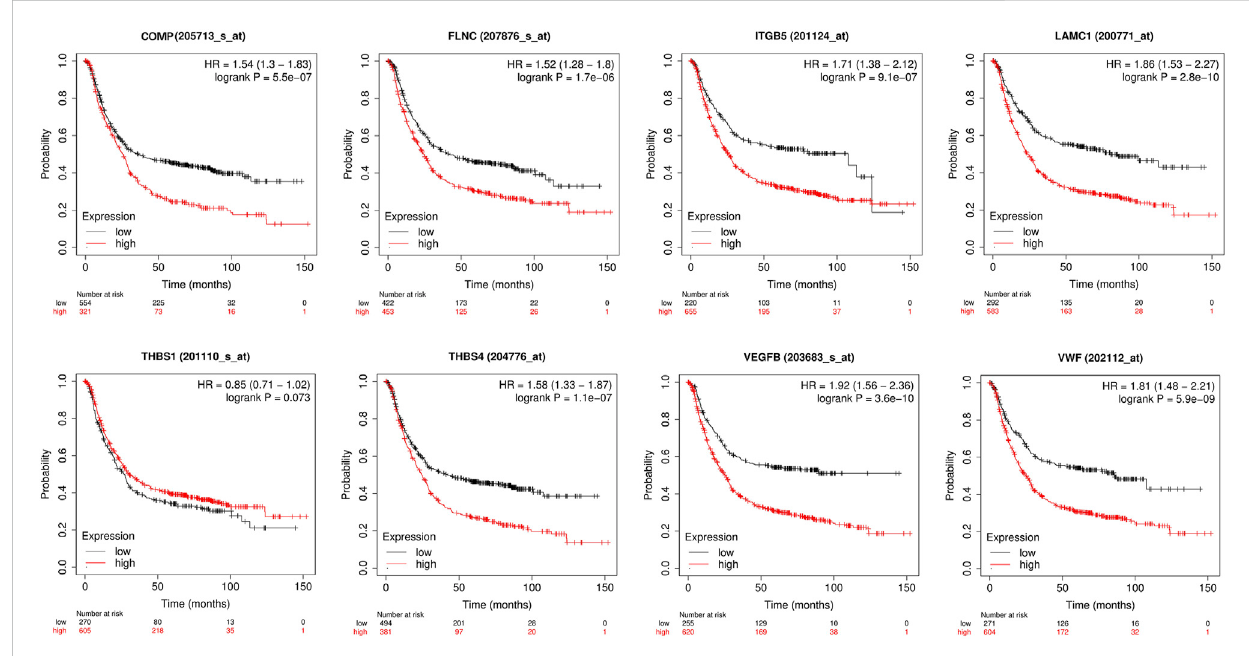
FIGURE 14 Univariate survival analysis of the focal adhesion-related genes using Kaplan-Meier curves.